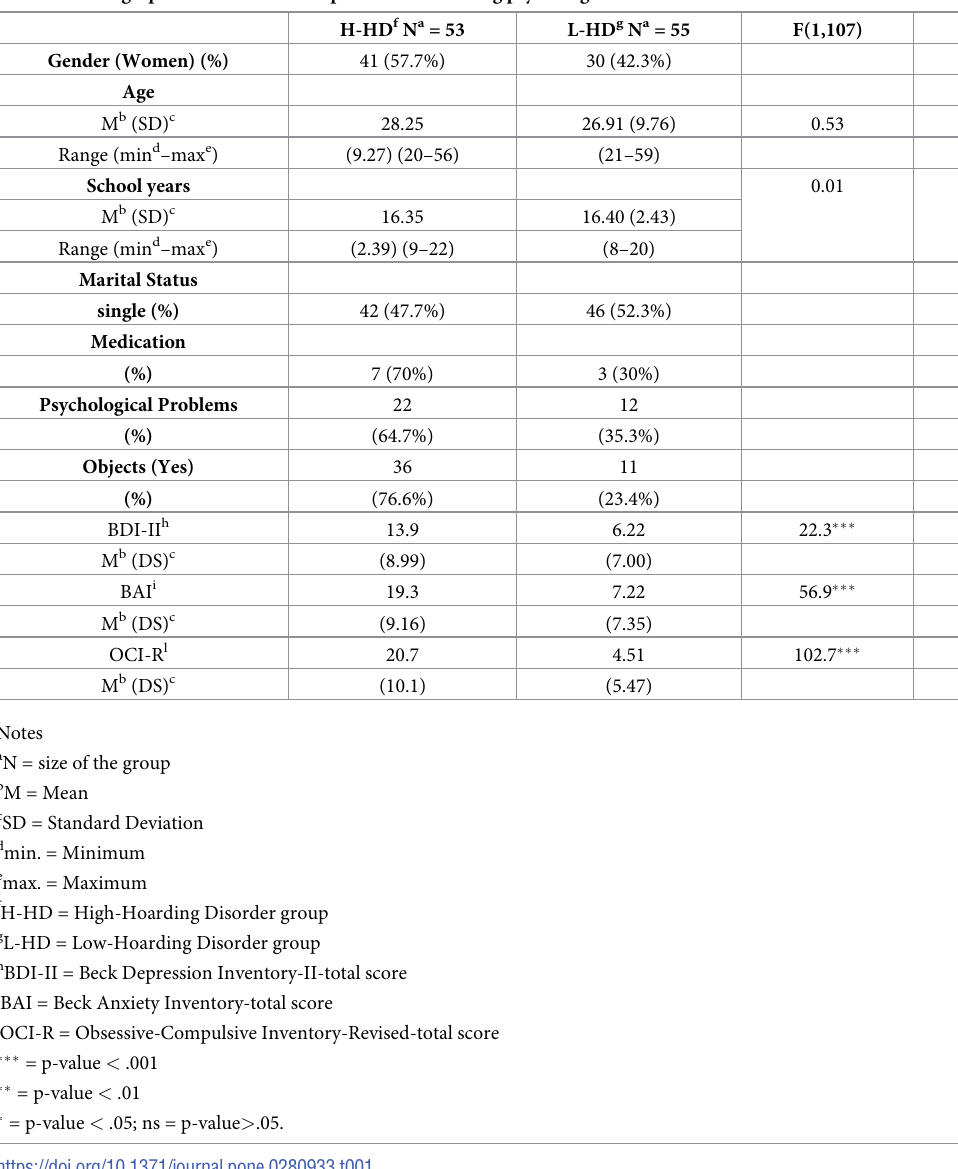
Table 1. Demographic features and comparisons considering psychological